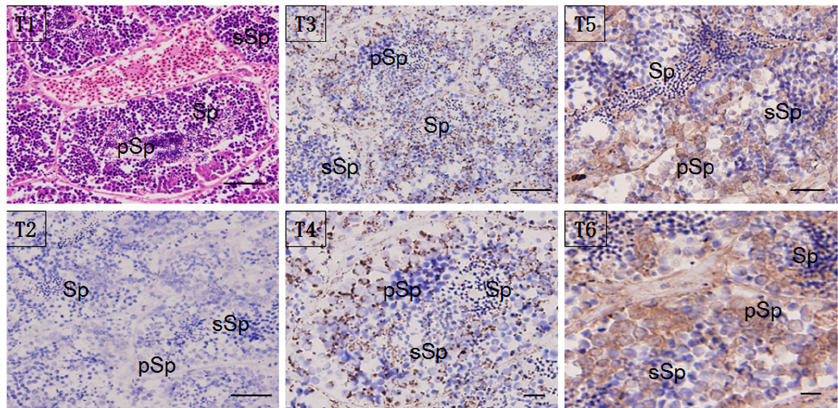
Figure 5. Localization of HSP60/HSP10 in the mature testis. Immunohistochemical (IHC) positive signals of HSP60/HSP10 immunolabeling are shown in brown. ( T1 ): the whole testis section stained with H&E; ( T2 ): negative control (NC); ( T3 ): different part and developmental phase of testis for IHC with anti-HSP60; ( T4 ): magnify for the IHC with anti-HSP60; ( T5 ): different part and developmental phase of testis for IHC with anti-HSP10; ( T6 ): magnify for the IHC with anti-HSP10, respectively. pSp: primary spermatocytes, sSp: secondary spermatocyte, and Sp: spermatids. Scale bar = 100 um.